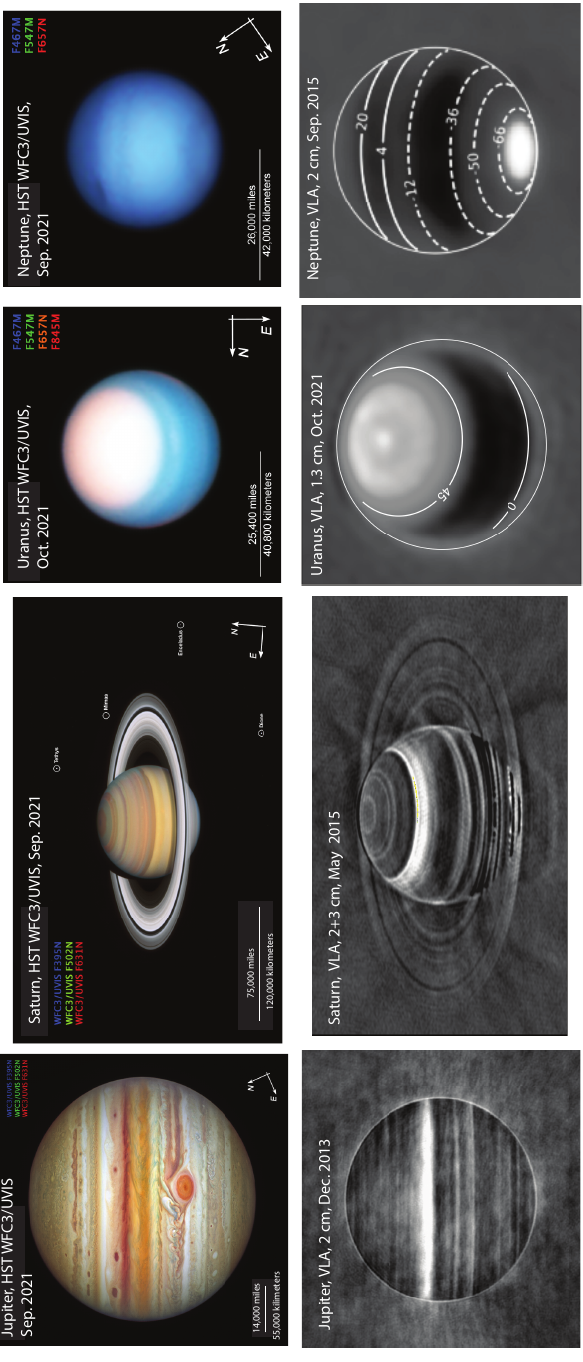
Figure 1. Top row: HST images of the four giant planets. (NASA/ESA/A. Simon/M.H. Wong). Bottom row: Longitude-smeared radio maps of the four giant planets as constructed from VLA data. The date and wavelength are indicated on each panel. These maps are discussed in detail in the following sections. (Images from: Jupiter [13], Saturn: Courtesy: Sault & de Pater, Uranus: [14,15], Neptune: